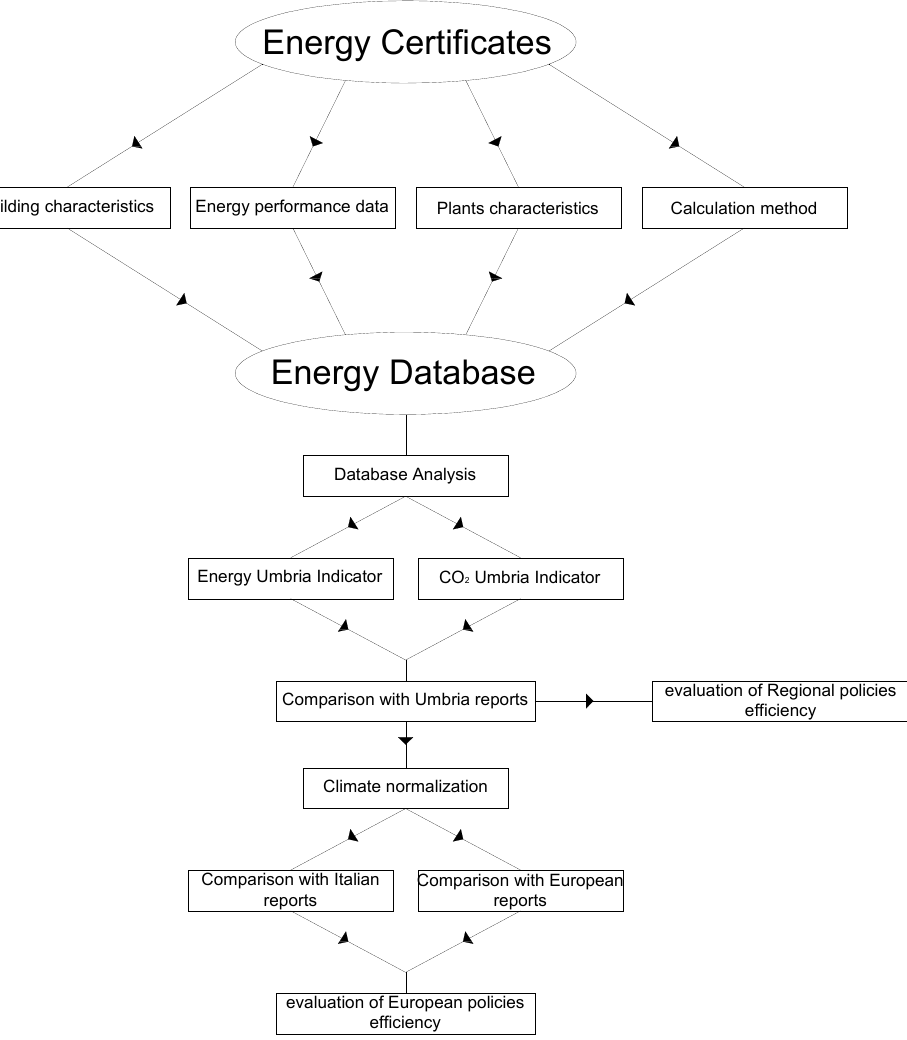
Figure 1. Methodology layout used to define Energy and CO 2 indicators by means of simulation